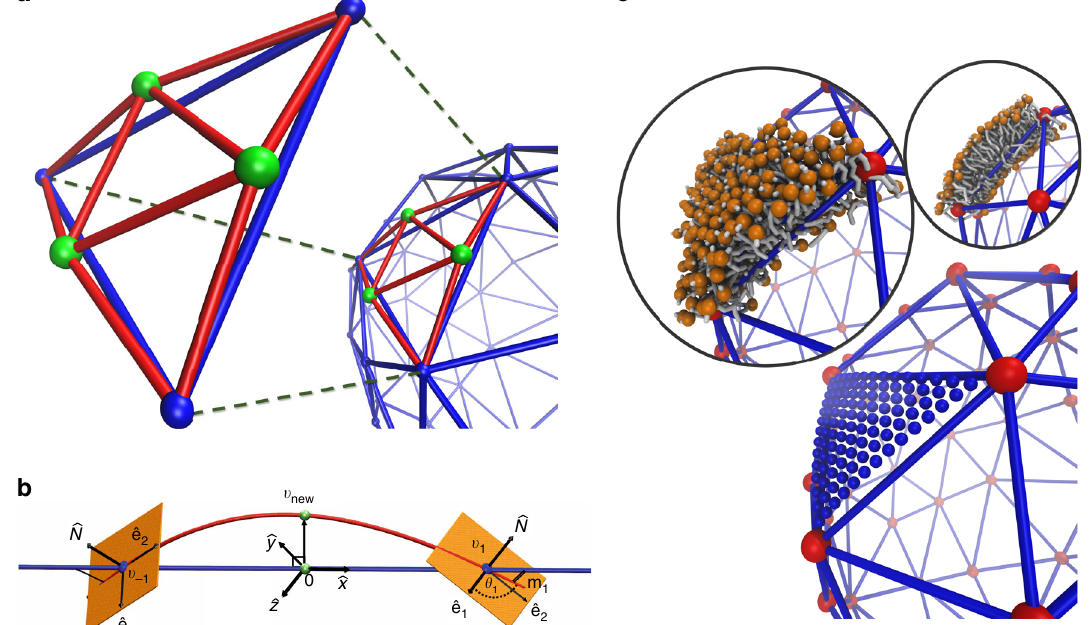
Fig. 2 Three-dimensional triangulation of a triangle. a One triangle is divided to four triangles by fi nding three new vertices in proximity of the mid-point of each of the edges of the original triangle. This increases the vertex number by a factor of 4. b Using the geometrical properties at two neighboring vertexes ð υ (cid:2) 1 ; υ 1 Þ , an estimate of the geodesic connecting two neighboring vertices can be found (red curve). c By performing several consecutive operations as shown in a , enough points are generated on each triangle for lipid placement.